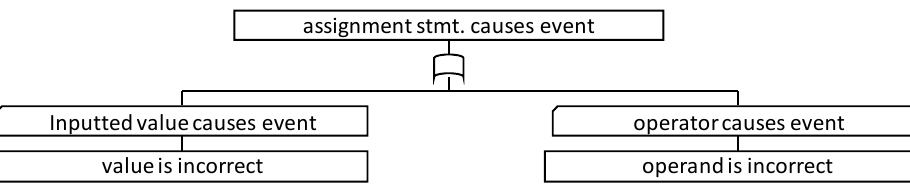
Figure 4. FTT for assign statement.